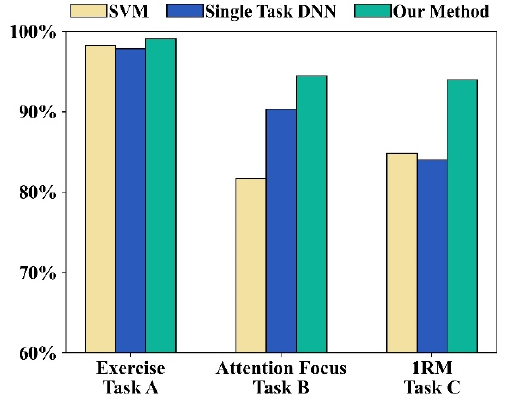
Figure 9. Comparison of recognition performance of different classification models.